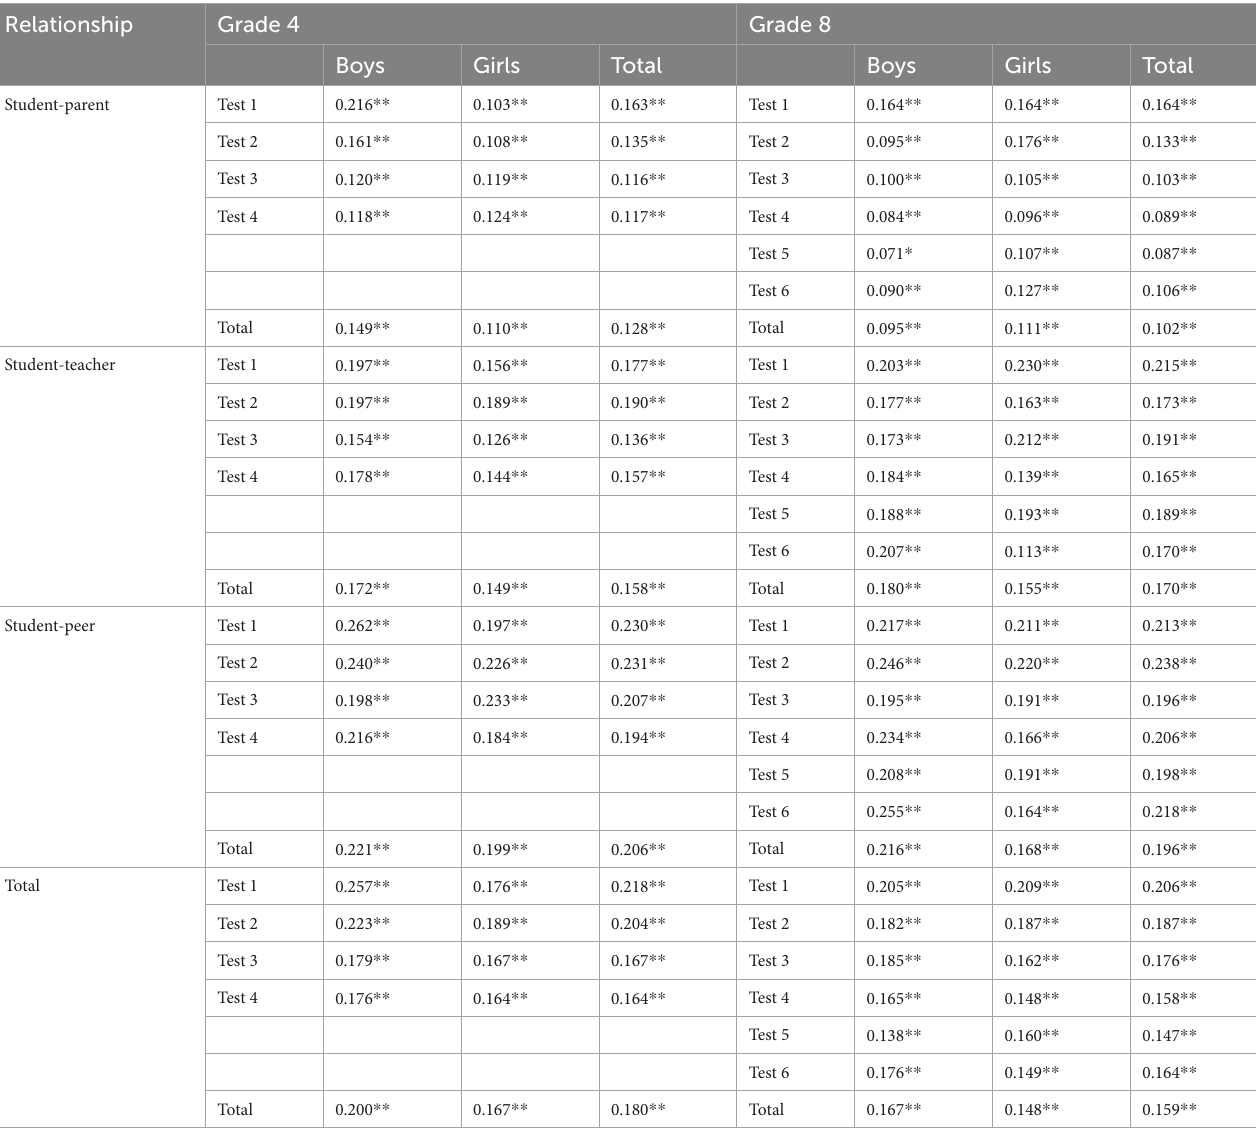
TABLE 8 Correlations between personal relationships and science scores. Relationship